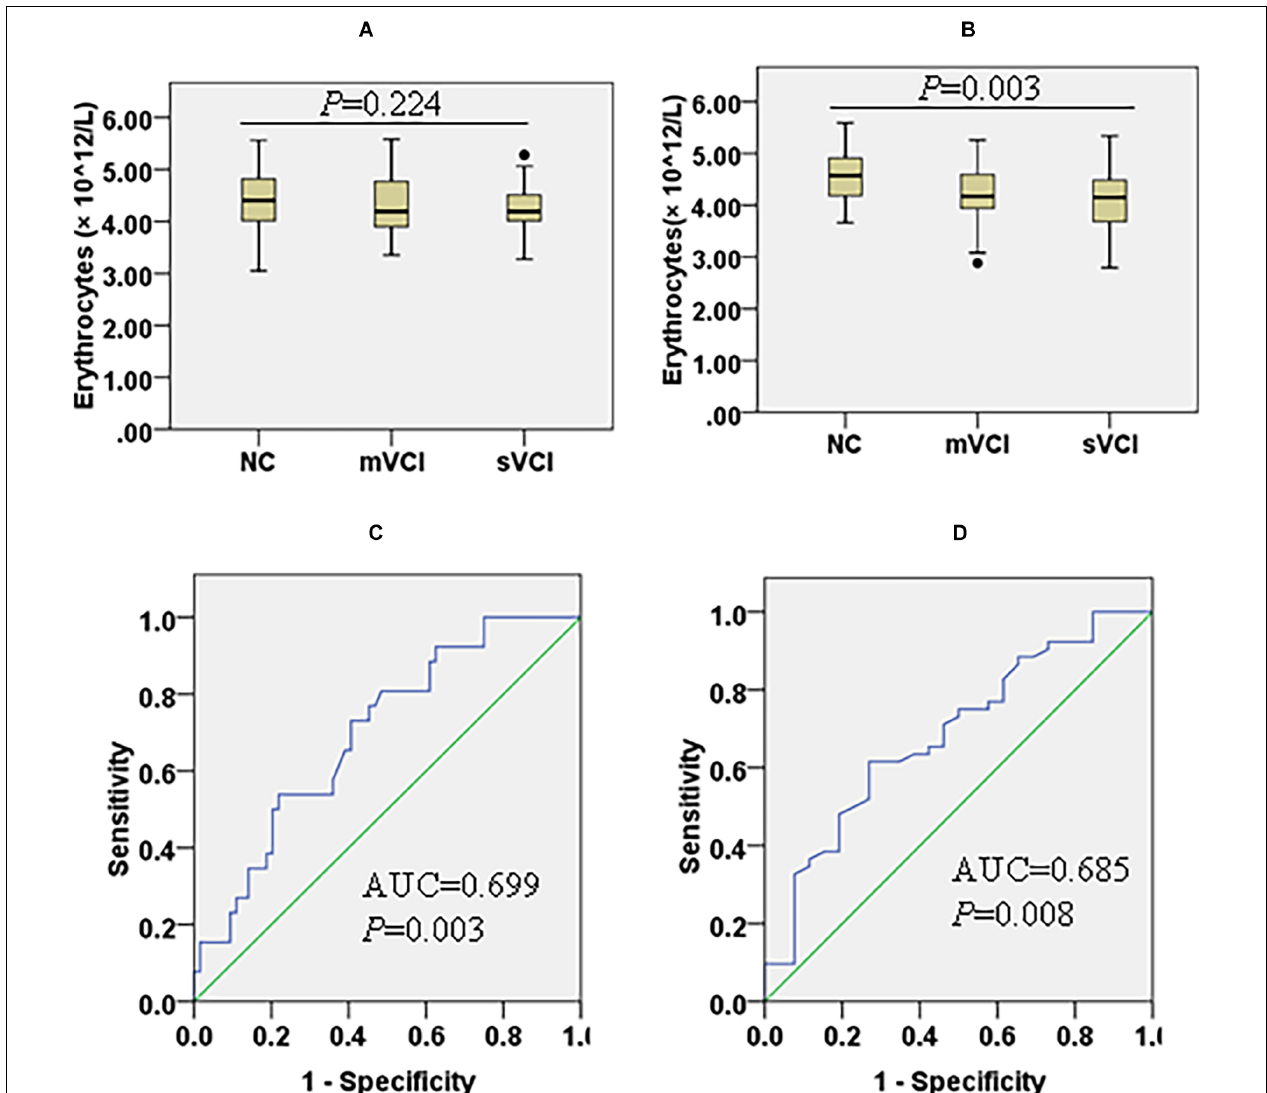
FIGURE 3 | Box diagram of erythrocytes in the mWMH and sWMH groups and ROC curves to predict the diagnostic value of erythrocytes for mVCI and sVCI in the sWMH group. Comparison of erythrocyte counts among patients with three cognitive levels in the mWMH (A) ( H = 2.993, P = 0.224) and sWMH (B) ( F = 6.094, P = 0.003) groups. (C) Diagnostic value of erythrocytes to sVCI in the sWMH group [AUC = 0.699, P = 0.003, 95% CI (0.586, 0.812)]. (D) Diagnostic value of erythrocytes to mVCI in the sWMH group [AUC = 0.685, P = 0.008, 95% CI (0.561, 0.810)]. AUC, area under the ROC curve; mVCI, mild vascular